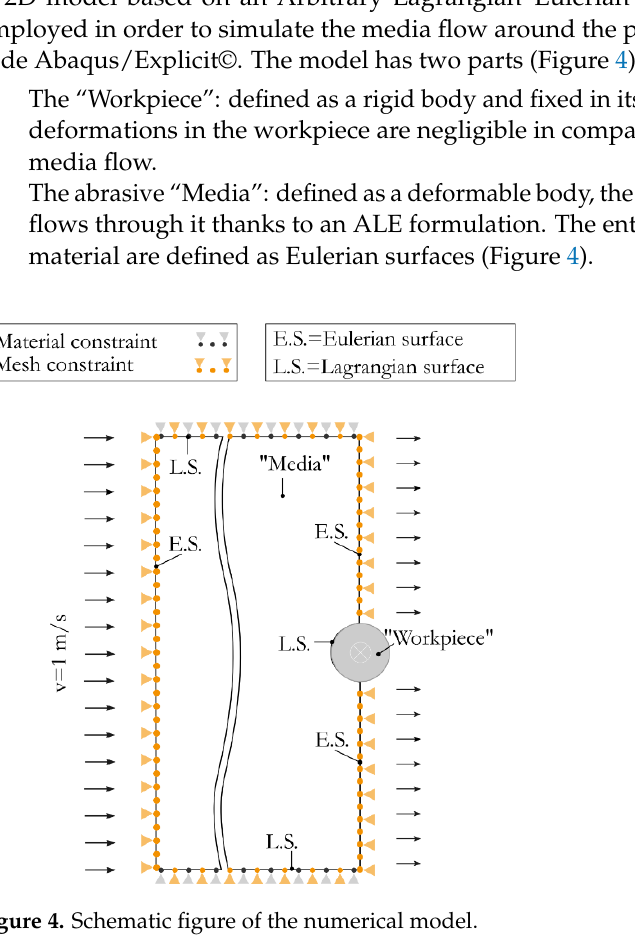
5 of 11 Figure 3. Drag finishing experimental results: Sa evolution according to the orientation angle ( α ) ( a – d ) of the surface and the abrasive media (BALL 1 and SCT 2 × 2). 3. The Numerical Model